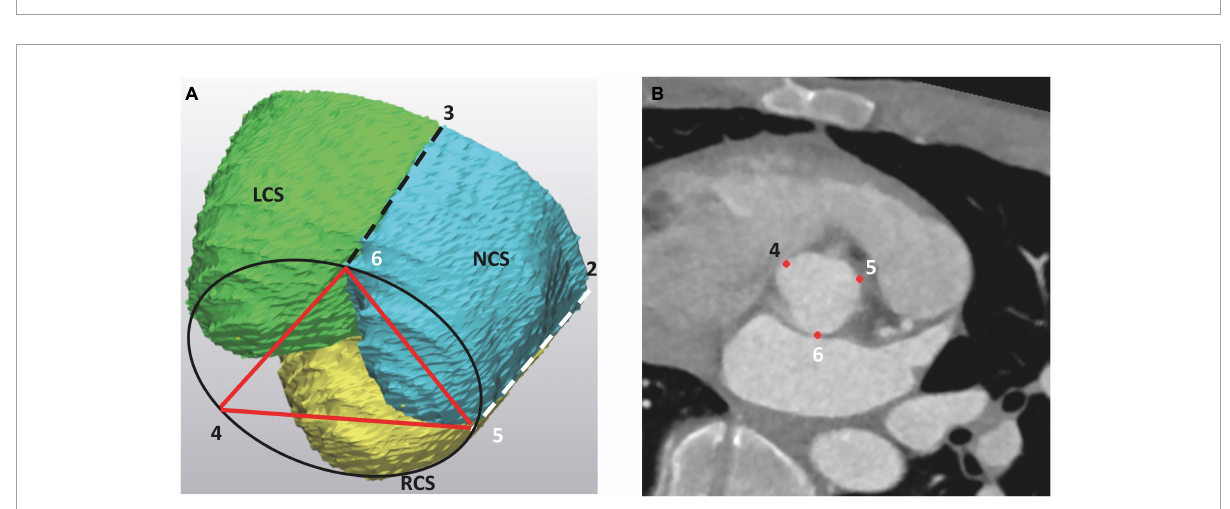
FIGURE3 The basal landmarks of the aortic root at the level of the aortic root base (AoB), as seen (A) on the 3D model of the aortic root and (B) on the angio CT scan. The basal landmarks “ 456 ” correspond to the deepest points at each IVT and are vertical projections of the three commissures into the AoB. On the 3D model, the LCS is marked as green, the RCS is yellow and the NCS is blue. The projection of the left and right commissure to the aortic root base is indicated by dashed lines. LCS, left coronary sinus; RCS, right coronary sinus; NCS, non-coronary